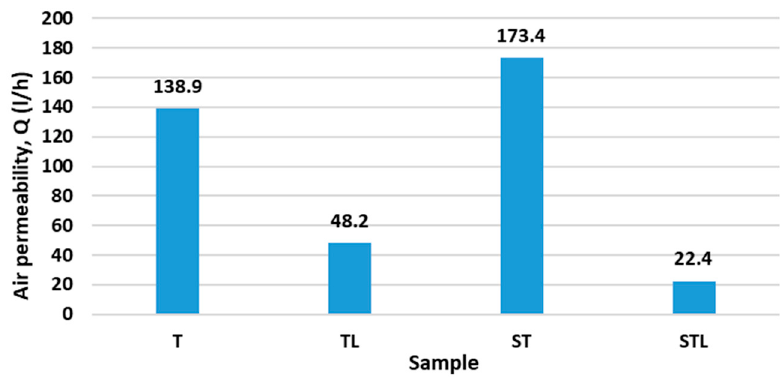
Figure 5. The results of air permeability.